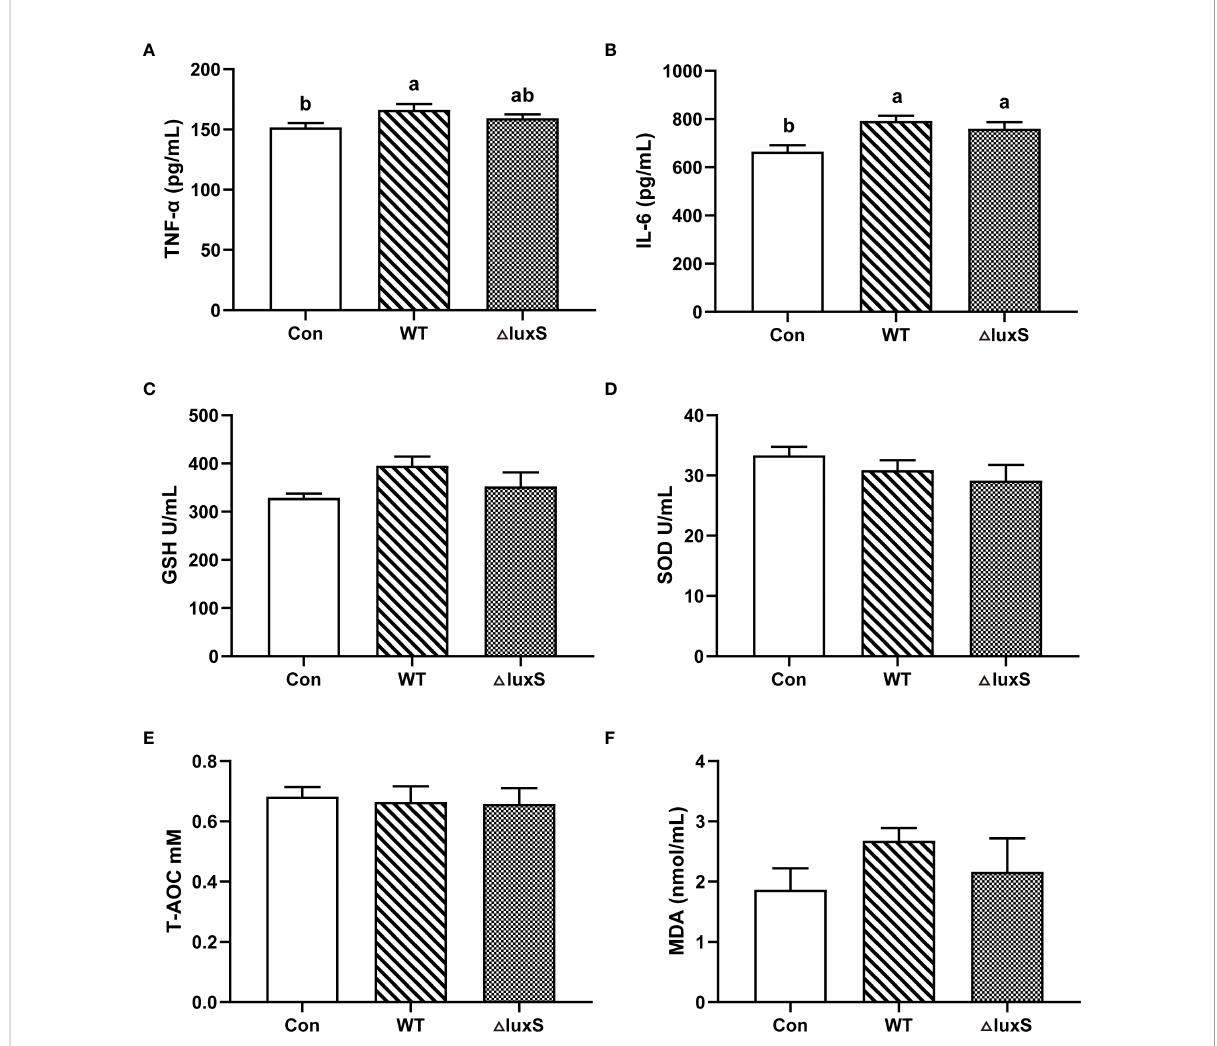
FIGURE 5 Serum biochemical parameters of weaned piglets. (A-F) TNF- a , IL-6, GSH, SOD, T-AOC, MDA, respectively. TNF- a , tumor necrosis factor- a ; IL- 6, interleukin-6; GSH, glutathione peroxidase; SOD, superoxide dismutase; T-AOC, Total antioxidant capacity; MDA, malonic dialdehyde. WT and D luxS groups were orally inoculated with 2 mL of LGG wild strain and luxS mutant strain, respectively, for 3 weeks before weaning on day 21. Con group was orally inoculated with PBS. Statistical signi fi cance performed using one-way analysis of variance for multiple comparisons. Mean values not sharing common letters are signi fi cantly different ( P <0.05). Values are shown as mean ± SEM,